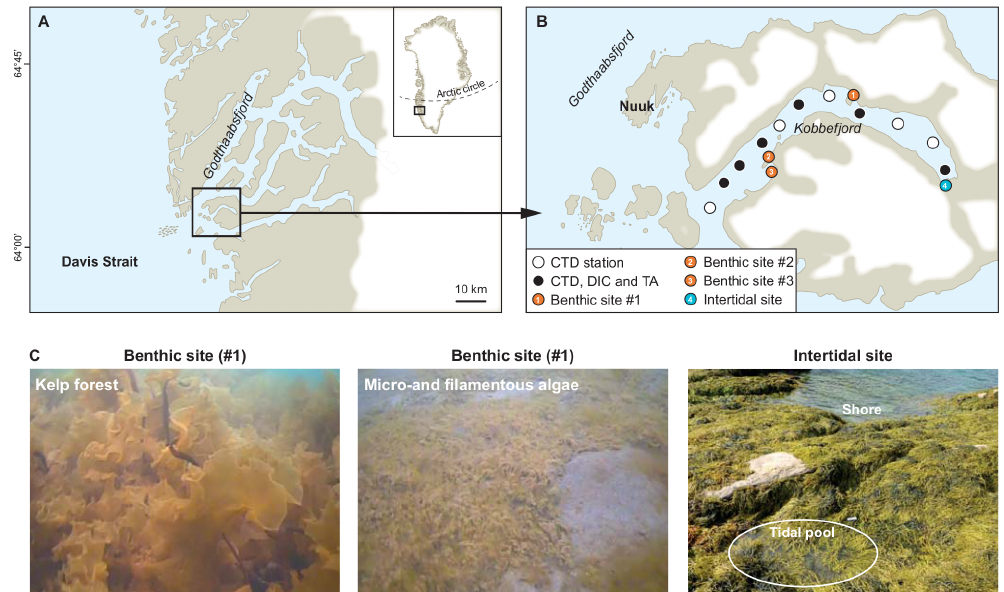
Figure 1. (a) Location of Kobbefjord, Nuuk. (a) Location of sampling sites in Kobbefjord: fjord-scale sites (CTD, C T , A T : filled circles; CTD: open circles), vegetated subtidal sites (open circles #1–3), and intertidal sites (open circles #4). (c) Photopanel of benthic habitats: a typical kelp forest habitat (dominated by Saccharina longicruris ) and habitat colonized by microalgae/scattered filamentous algae (example from site #1, representative of sites #1–3 in map) and a vegetated intertidal pool and the adjacent vegetated shore dominated by Ascophyllum nodosum and Fucus spp. (site #4 in